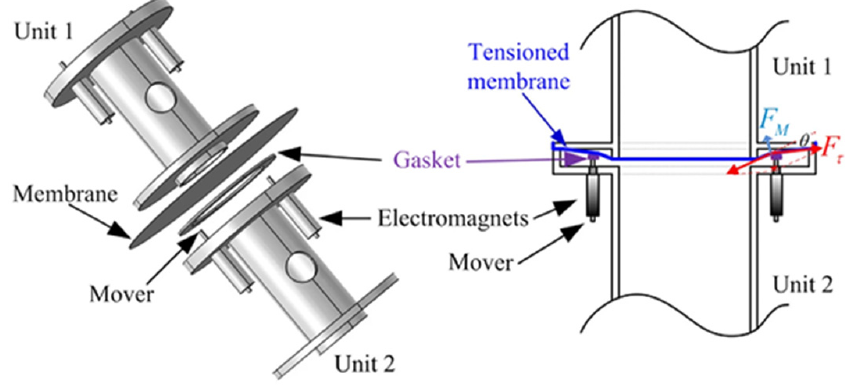
Figure 11. Structure of the active meta-unit with an electromagnetic tuning mechanism. A membrane is tensioned using electromagnetically-operated clamps attached to the pipe exterior [33].